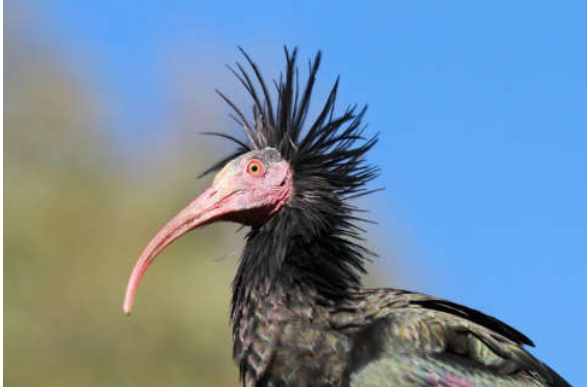
Figure 1. Portrait of an adult Northern Bald Ibis. Photo J. Fritz.